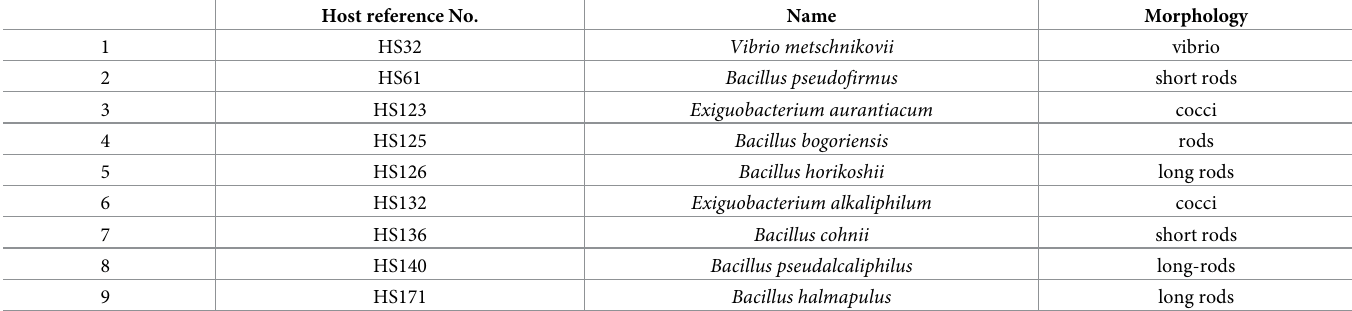
Table 1. Summary of bacterial hosts’ characteristics. Hosts and their characteristic morphologies as observed under phase contrast microscope ( × 400). Host reference